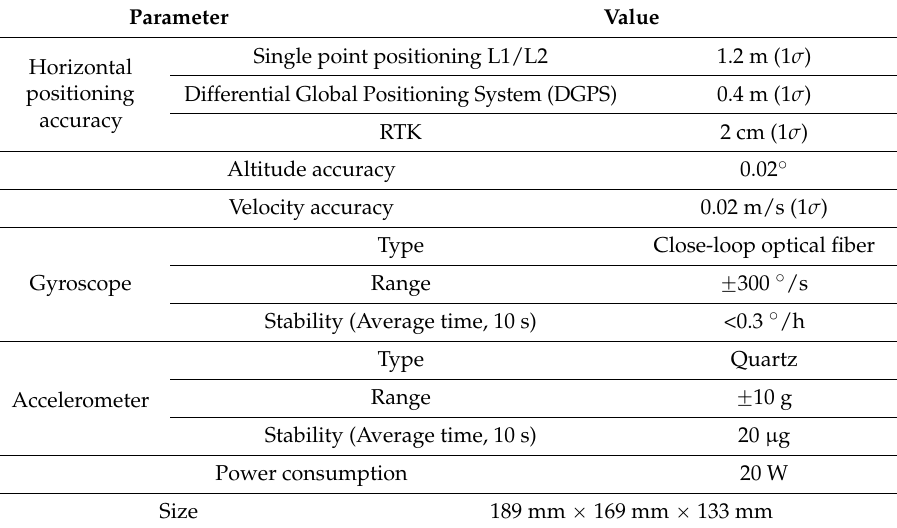
Table 3. Main parameters of GI7660.